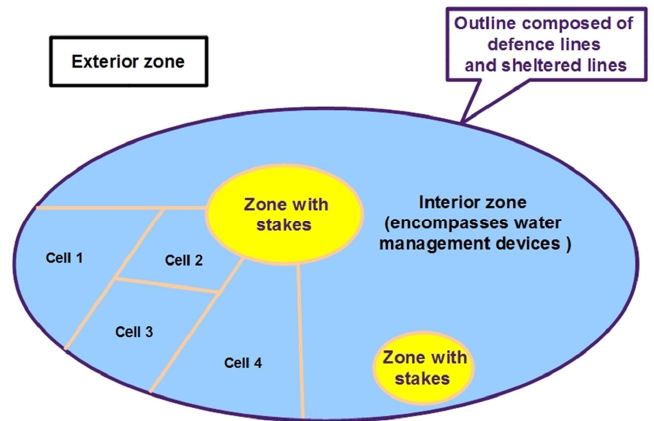
Figure 3. Schematic representation of cells within a protection system.